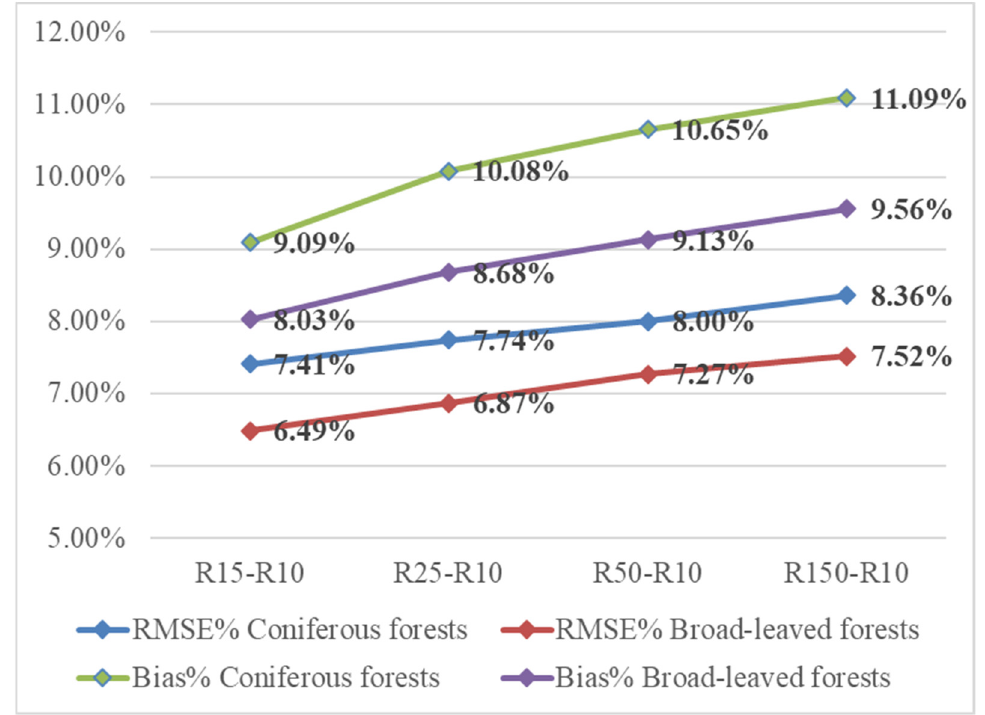
Figure 9. Difference in the accuracy (RMSE, bias) of D. pierrei height obtained under R10 and the four other point cloud densities (R15, R25, R50, F150).